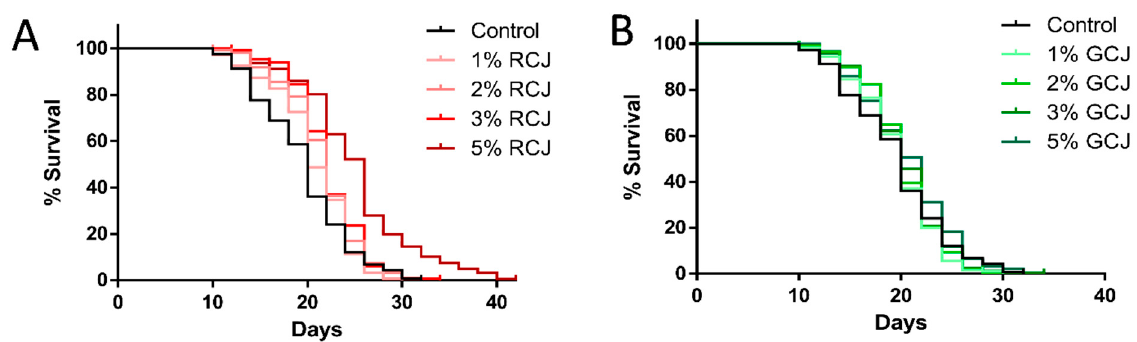
Figure 6. Effect of red cabbage juice (RCJ) and green cabbage juice (GCJ) on the lifespan of wild-type C. elegans . Synchro- nized L4 larvae worms were treated with or without 1%, 2%, 3%, and 5% RCJ ( A ) and GCJ ( B ). Three independent trials were performed. Table 3. Statistical analysis of the lifespan of C. elegans . Condition